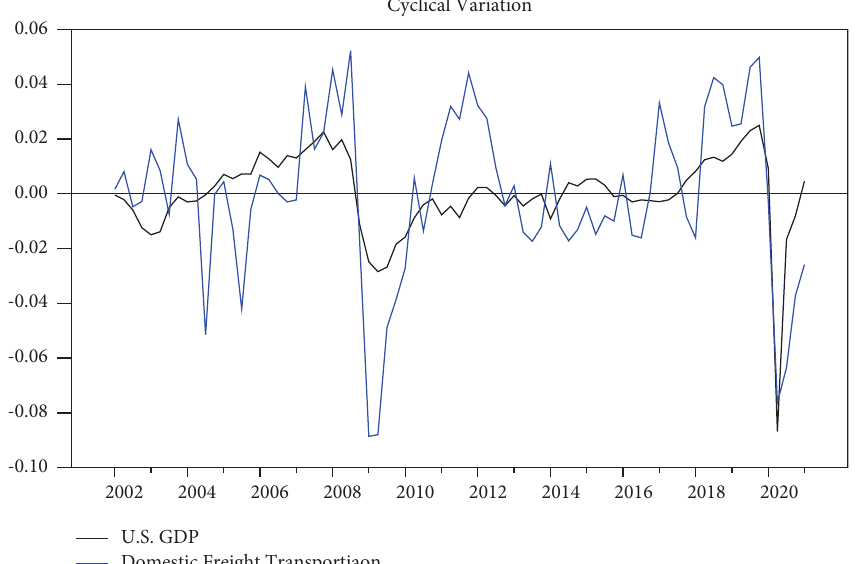
Figure 1: Te cyclical variation of U.S. GDP and seaborne freight volume. Source: U.S. FRED and Korea Port-mis [25, 26].